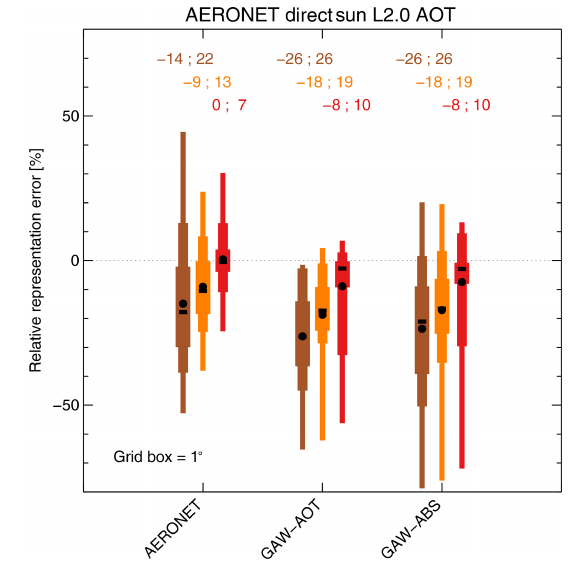
direct sun L2.0 and GAW and a model grid-box size of 1 ◦ . The colours indicate different collocation protocols: yearly (brown), daily (orange) and hourly (red). Numbers on top are the means of the errors and means of the signless